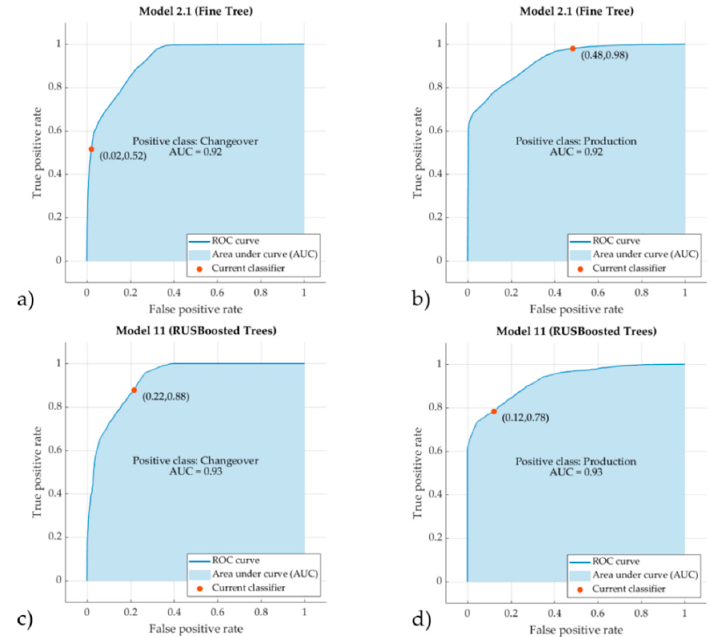
Figure 6. ROC-Curve of Fine Tree Algorithm with production as positive class ( a ) and changeover as positive class ( b ); ROC-Curve of RUSBoostedTree Algorithm with production as positive class ( c ); and, changeover as positive class ( d ).